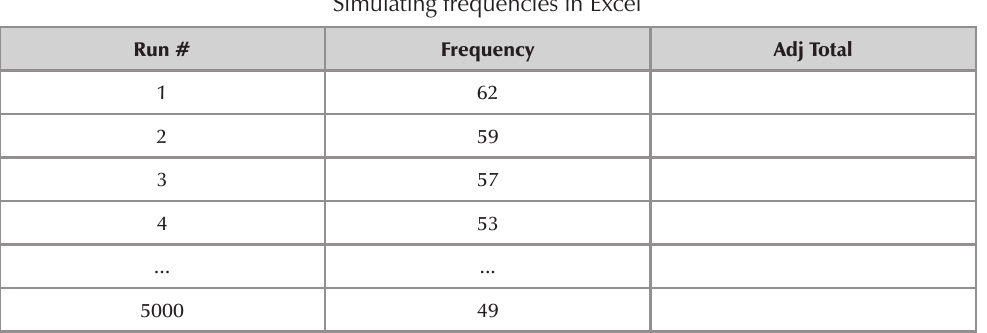
Simulating frequencies in